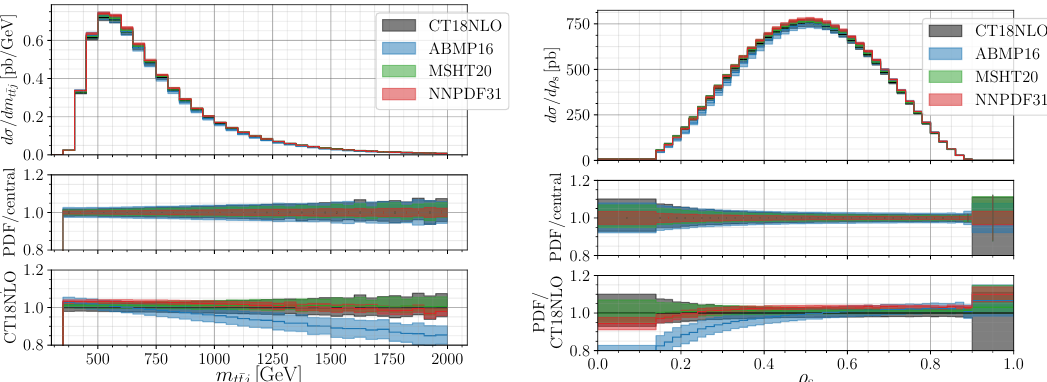
Figure 21 . Predictions for the m (left) and ρ s (right) distributions in a LO computation with t ¯ tj scale µ 0 = H B / 4 , including PDF uncertainties of the ABMP16, CT18, MSHT20 and NNPDF3.1 T NLO PDF sets. PDF uncertainty bands have been computed according to the prescriptions of the various PDF collaborations, which differ among each other. The CT18 NLO uncertainty band is rescaled to 68% C.L. The α s ( M Z ) value is fixed according to the prescription associated to each PDF set and two-loop α s evolution is considered. For ρ s < 0 . 85 , corresponding to m > 400 GeV, t ¯ tj the percentage size of the PDF uncertainty band in a full NLO computation would be approximately the same as the one shown in these plots (see also figure 19).